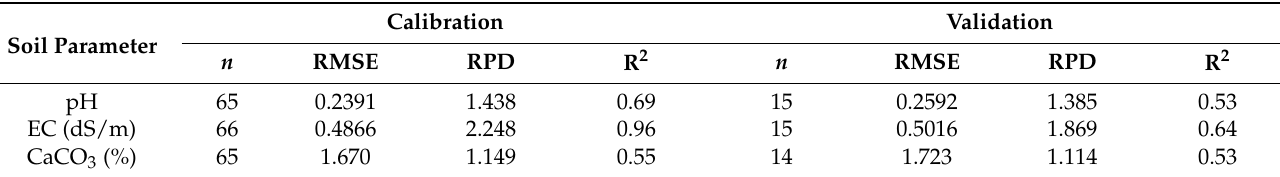
Table 9. The obtained data of ANN models for each soil parameter.